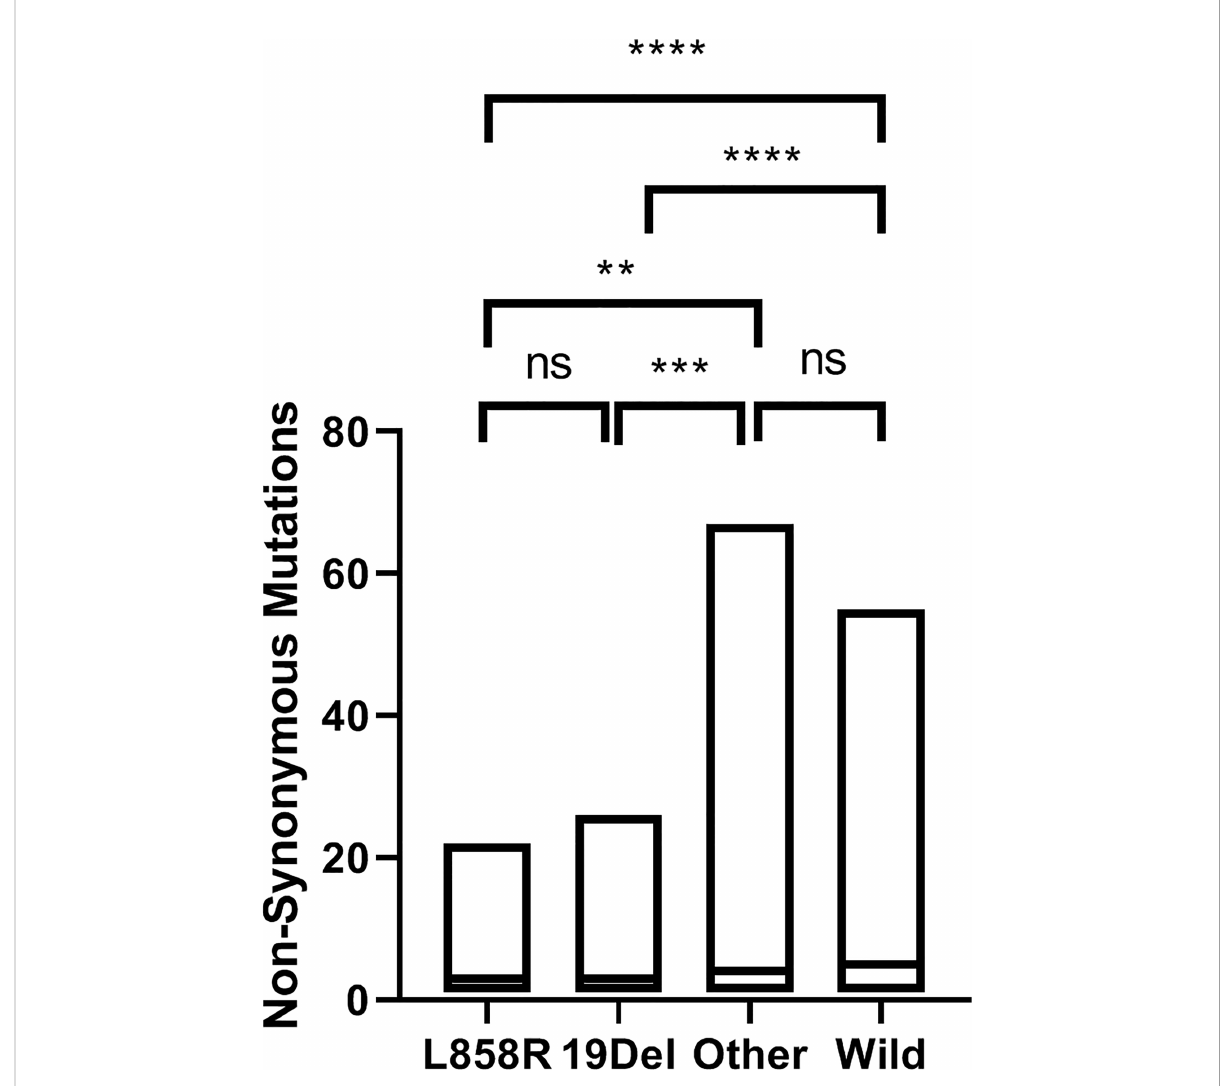
FIGURE 7 Non-synonymous mutations in NSCLC from our cohorts. The median non-synonymous mutations of EGFR L858R (n=421) was three, of EGFR 19del (n=367) was three, of EGFR other (n=145) was four and of EGFR WT (n=604) was fi ve. **p < 0.01; ***p < 0.001; ****p < 0.0001 , ns, no signi fi